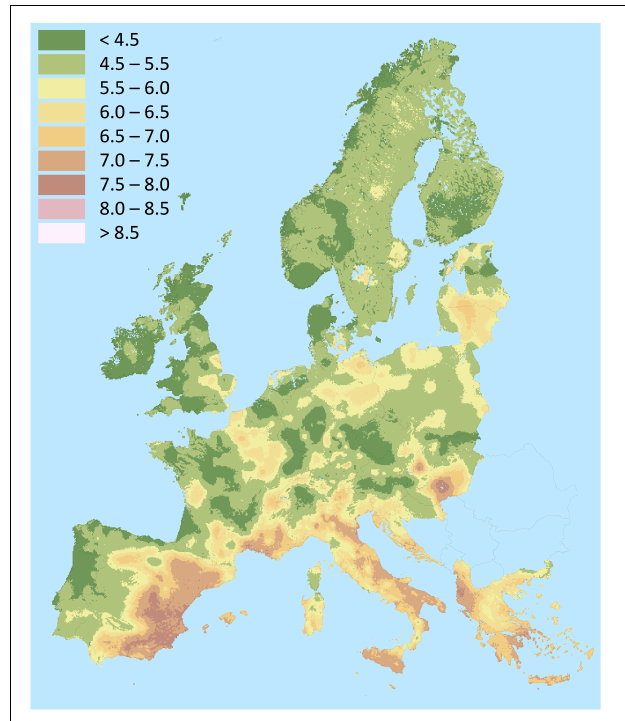
FIGURE 1 | Map of soil pH in Europe. Source: Land Resources Management Unit, Institute for Environment and Sustainability, European Soil Data Centre (ESDAC), esdac.jrc.ec.europa.eu, European Commission, Joint Research Centre (Panagos et al.,